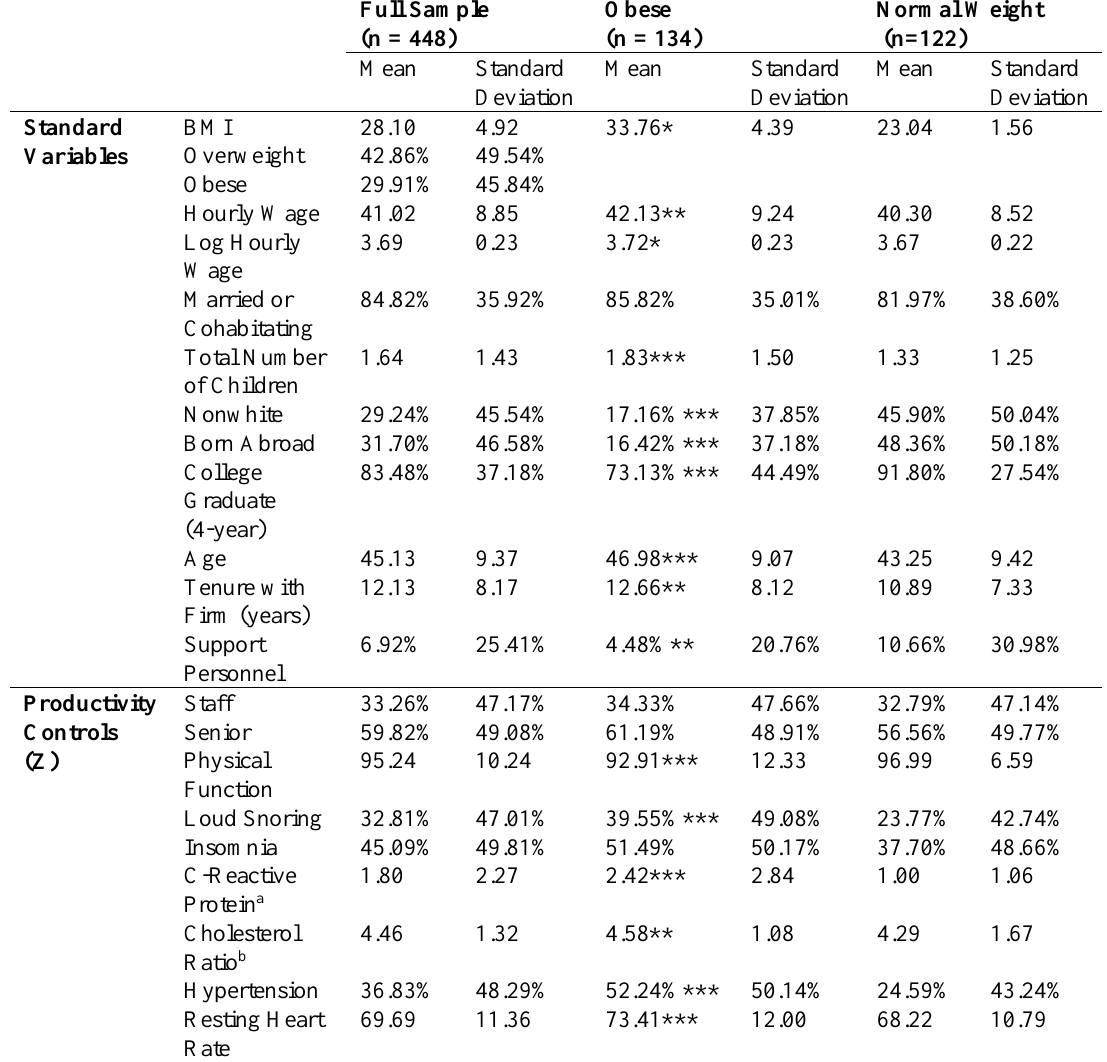
Table 1b: Summary statistics